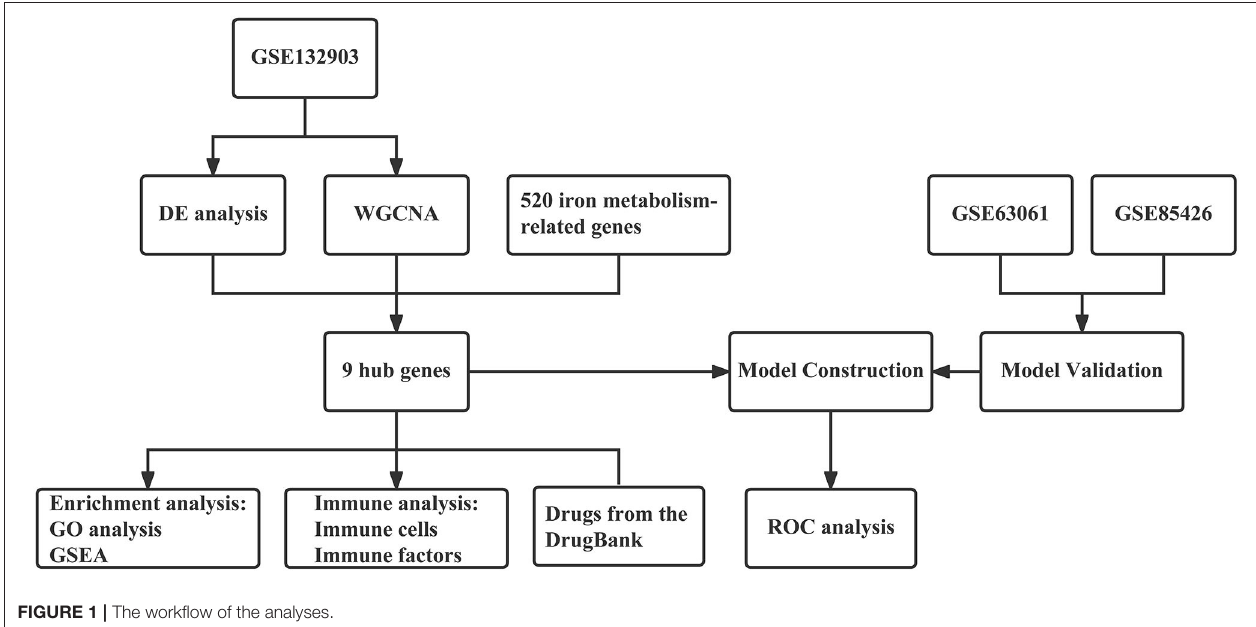
FIGURE 1 | The workflow of the analyses.